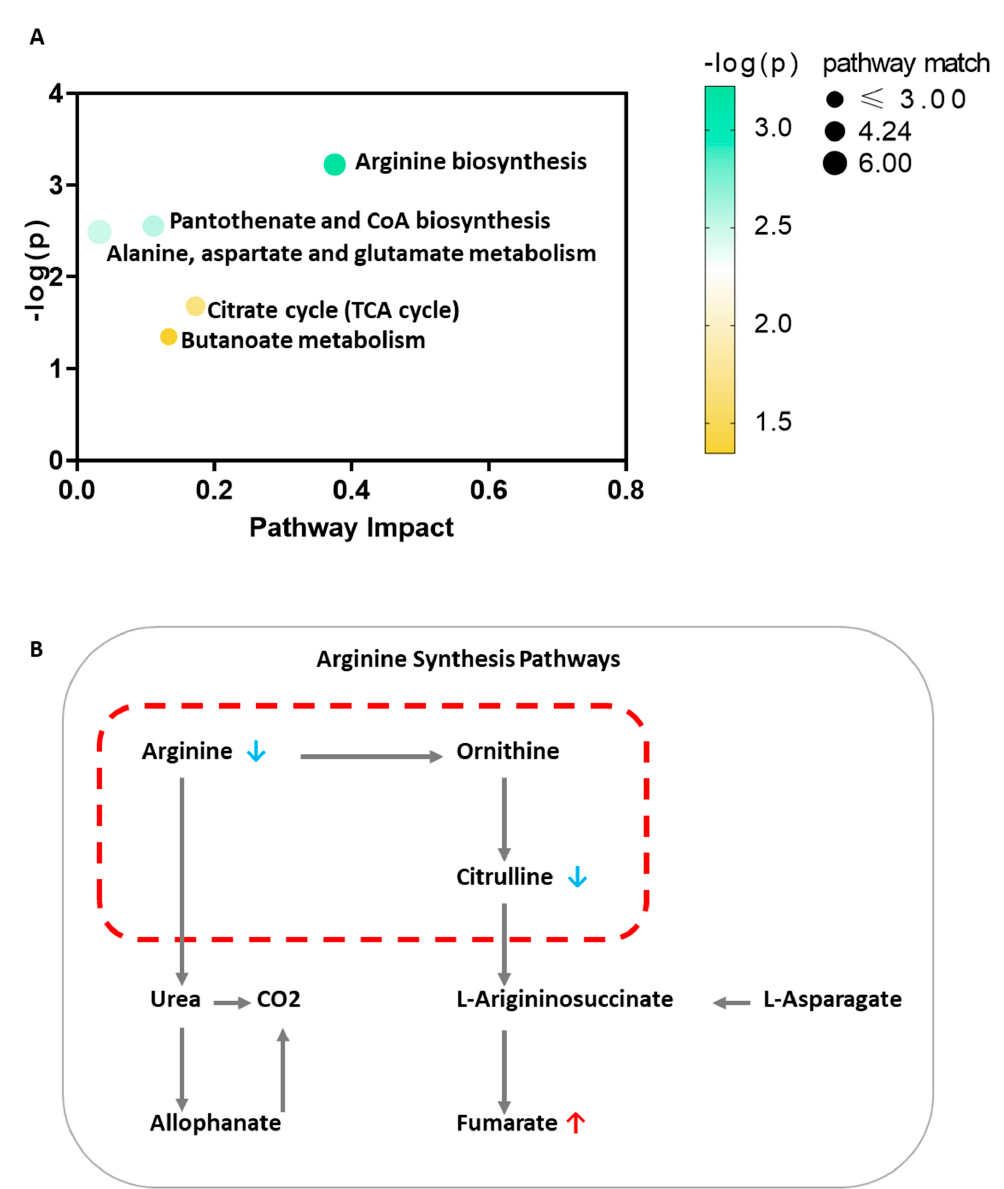
Figure 3. Significantly altered pathways during chronic persistent asthma. ( A ) Significantly altered pathways during chronic persistent asthma. X axis indicated the pathway impact and Y axis indicated minus log transformed p value. The node size of each pathway indicated the pathway match. ( B ) Arginine synthesis pathways indicating decreased Arginine and Citrulline, and increased Fumarate.